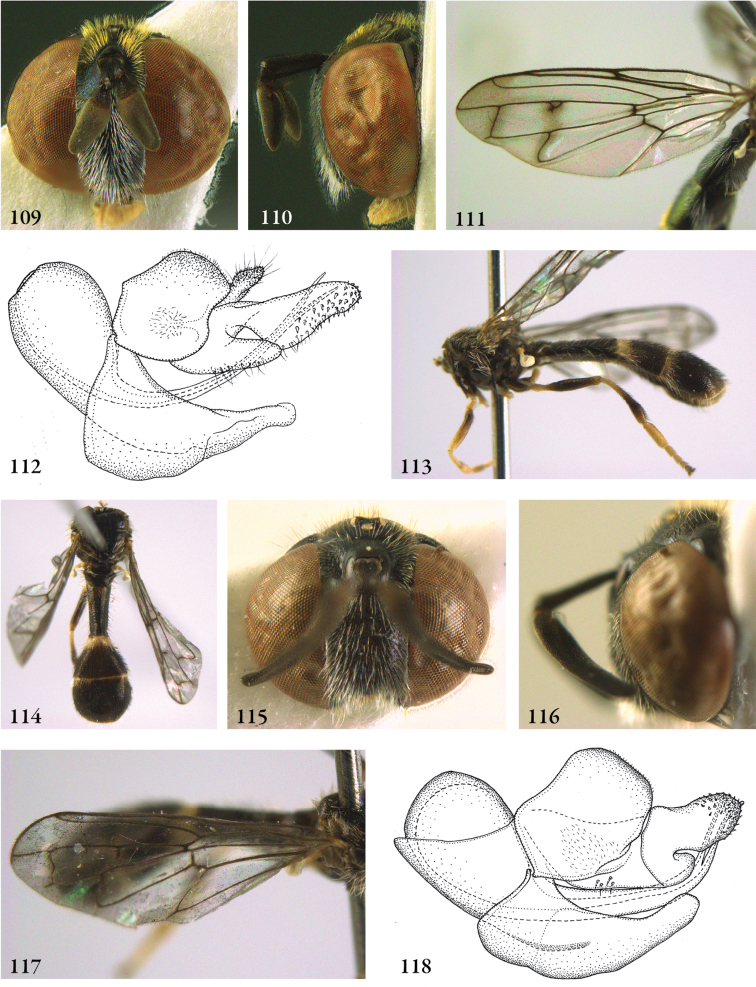
109–112
Indascia gigantica male (holotype): 109 head frontal 110 head lateral 111 wing 112 genitalia lateral 113–118
Indascia spathulata male (holotype): 113 habitus lateral 114 dorsal 115 head frontal 116 head lateral 117 wing 118 genitalia lateral.